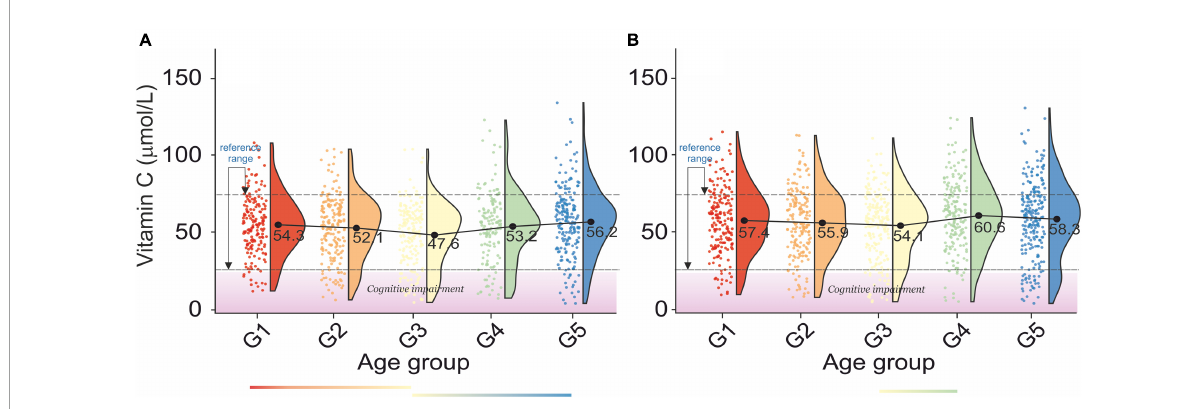
FIGURE6 Rain-cloud plots of age-dependent changes in vitamin C levels as a function of age group G1: 20 ≤ 1 < 30, G2: 30 ≤ 2 < 40, G3: 40 ≤ 3 < 50, G4: 50 ≤ 4 < 60, and 60 ≤ G5 < 70 years of age-stratified by gender (A) men, (B) women. Mean values for a specific sample are truncated to one decimal place. Color bars refer to statistically significant differences between groups at P < 0.05. A shaded area corresponds to an increased risk of cognitive impairment vitamin levels (86).